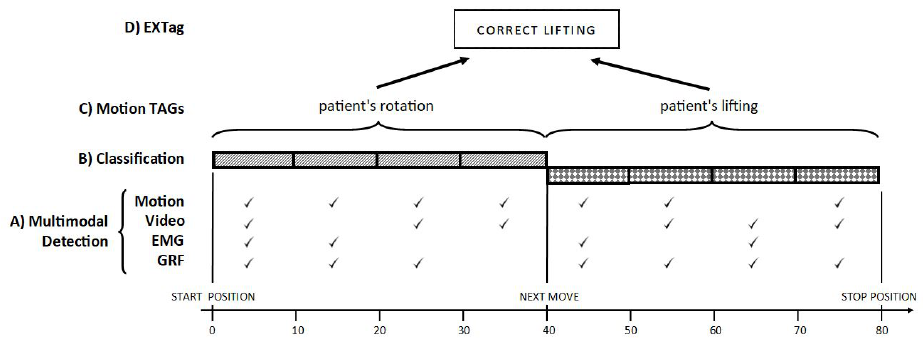
Figure 3. The EXTag concept with four level of operations